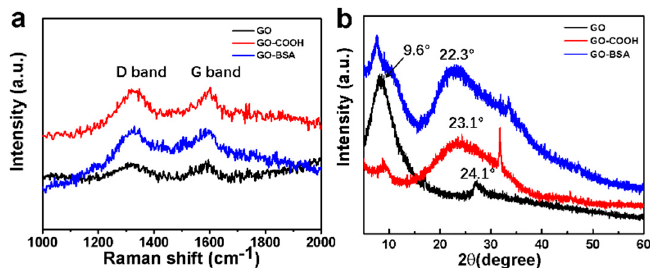
Figure 4. Structural and property characterizations of GO–BSA membranes: ( a ) Raman spectra of GO and GO–BSA hybrid membrane. ( b ) XRD patterns of the GO and GO–BSA hybrid membrane.